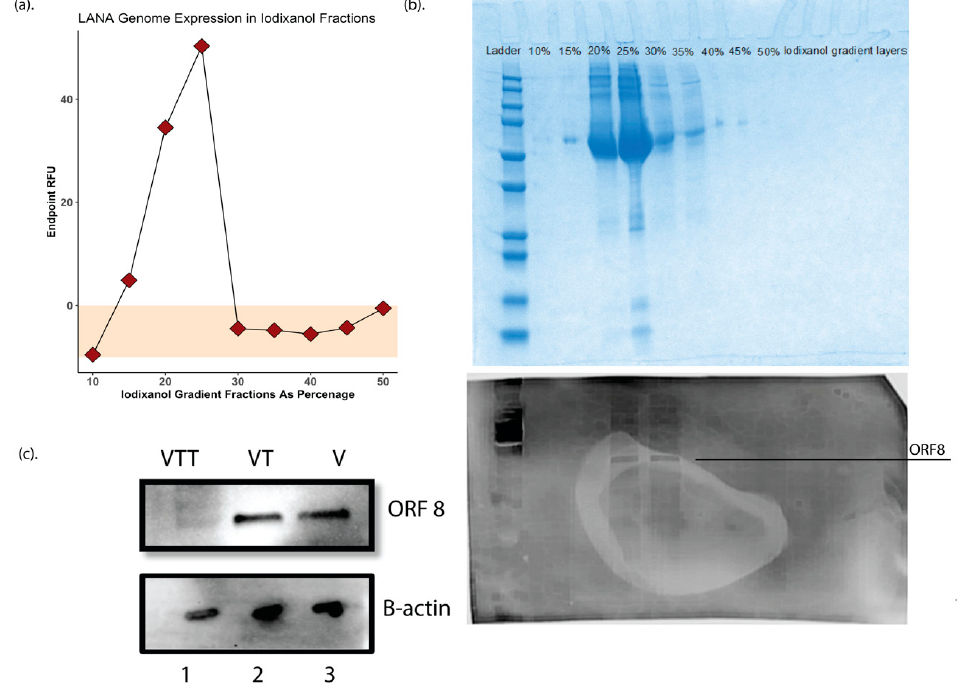
Figure 1. ( a ) Endpoint RFU qPCR using LANA genome on Iodixanol fractions. ( b ) Top Coomassie blue staining of the Iodixanol gradient fractions. ( b ) Bottom Western blot using gB/ORF8 antibody on different iodixanol gradient fractions to ensure the quality of the virion purification, based on the data, only fractions of 22–24% Iodixanol containing virions was used for further processing. This fraction was labeled as fraction V. ( c ) Western blot for gB/ORF8 on proteins from trypsin digested (VTT) and purified (VT) fractions as well as virions.